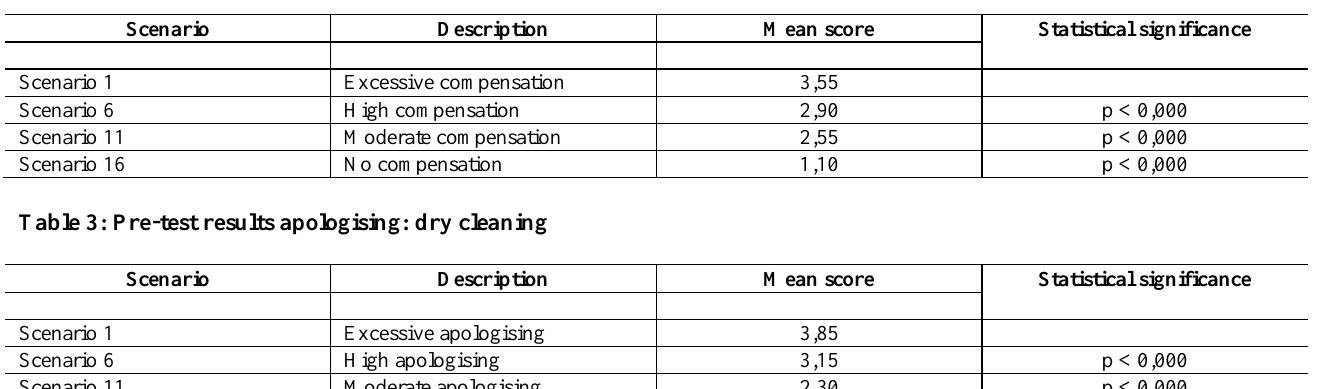
Table 2: Pre-test results compensation: dry cleaning